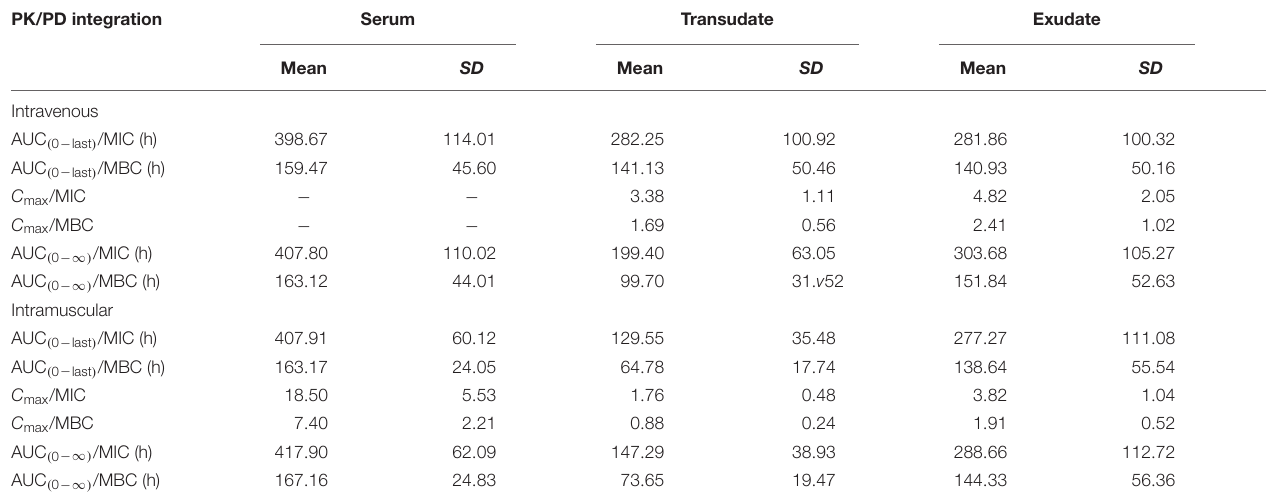
TABLE 5 | In vivo PK/PD integration parameters for tulathromycin after i.v. or i.m. administration and in vitro measurement of MIC (mean ± SD, n = 6). PK/PD